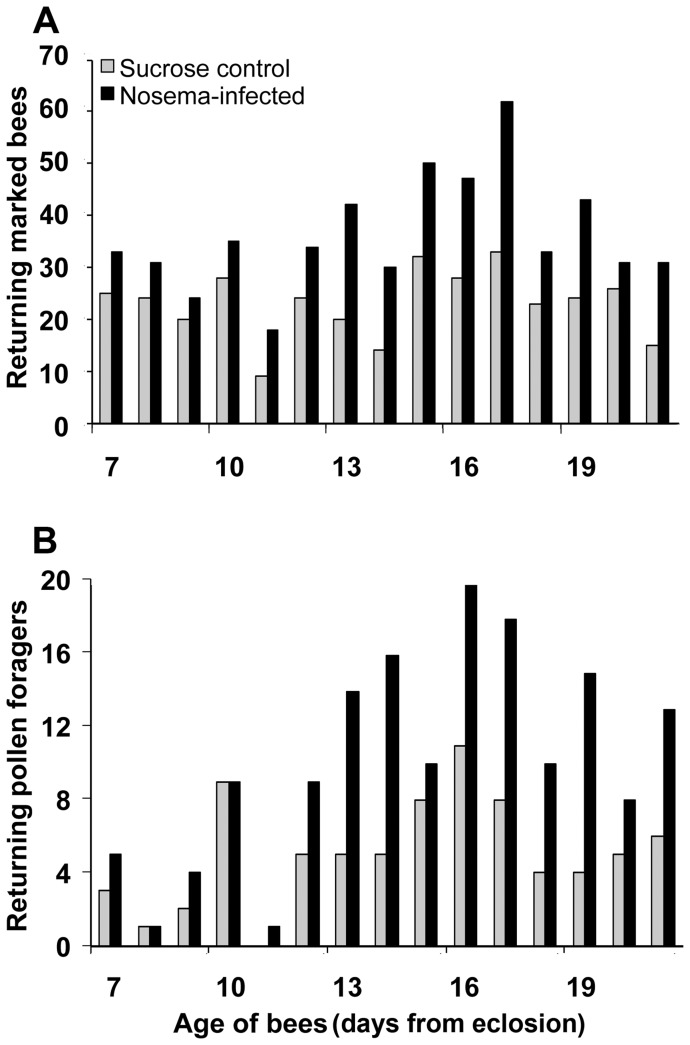
Honey bees infected with N. ceranae forage prematurely. A.Distribution of returning marked bees during a daily 30-min observation period from 7 through 21 days of age after eclosion. Data are summarized over 3 independent trials. B. Distribution of returning marked pollen foragers collected daily during a 30-minute observation period from 7 through 21 days of age after eclosion. Data are summarized over 3 independent trials. Significantly more marked pollen foragers were collected from the Nosema-infected group compared to controls for the 3 trials combined (χ2 = 26.38, p<0.0001).